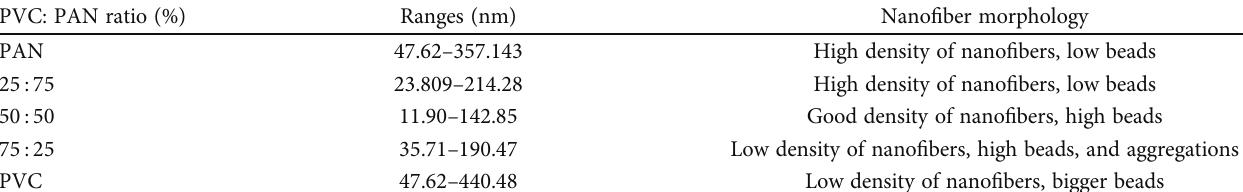
Table 2: The results of ranges of nano fi ber diameters and morphological properties of pure and blended nano fi bers. PVC: PAN ratio (%) Ranges